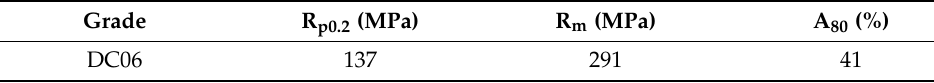
Table 2. Mechanical properties of the material sheet at quasistatic load.